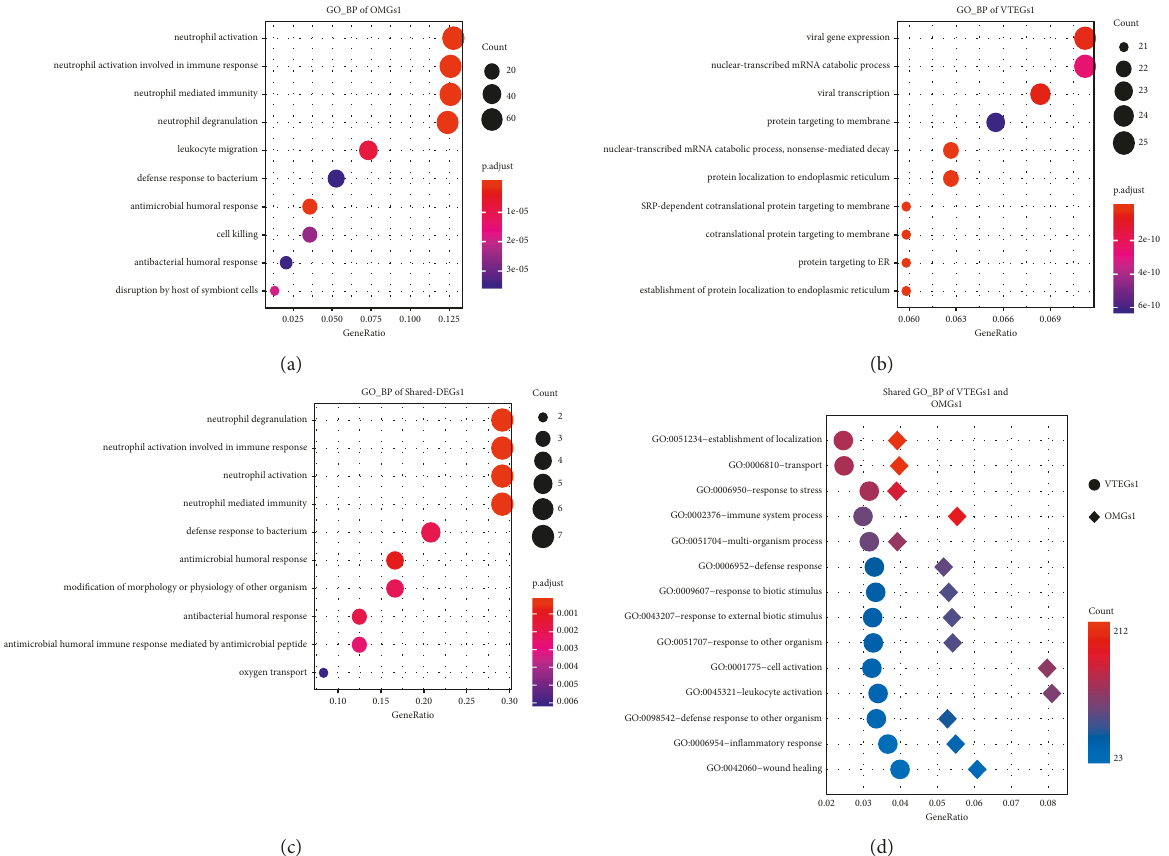
Figure 3: Results of the GO-BP terms enrichment analyses for (a) OMGs1, (b) VTEGs1, and (c) shared DGEs1 and (d) shared GO-BP enrichment of VTEGs1 and